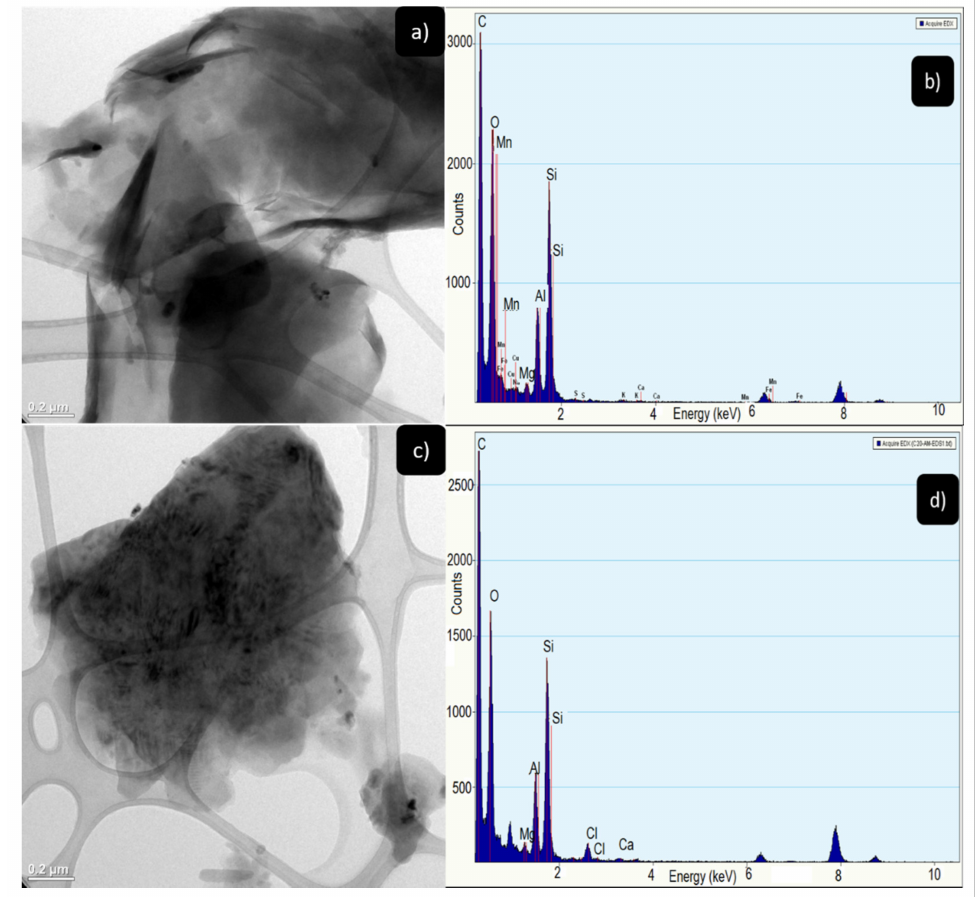
Figure 5. ( a ) TEM images closite 20A, ( b ) EDS spectra of the closite 20A, ( c ) TEM images C20AM 120 and ( d ) EDS spectra of the C20A